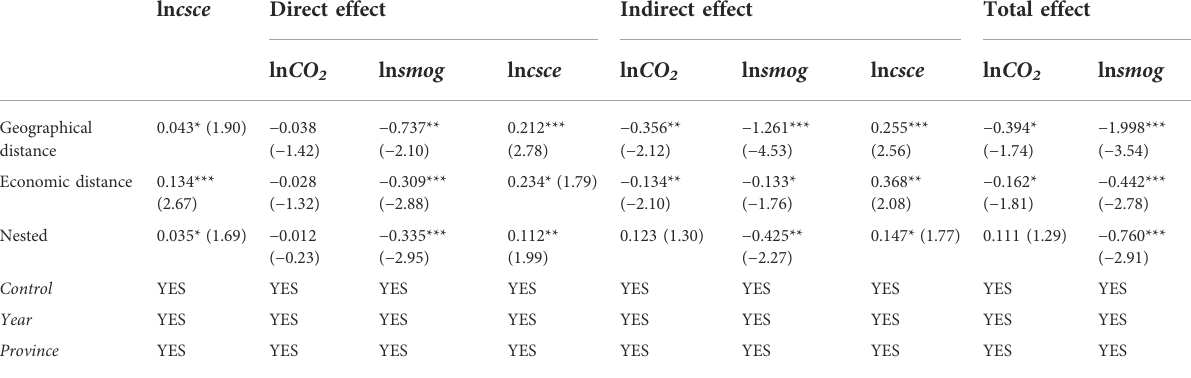
TABLE 5 Decomposition of the effects of the digital economy on carbon-haze governance ln